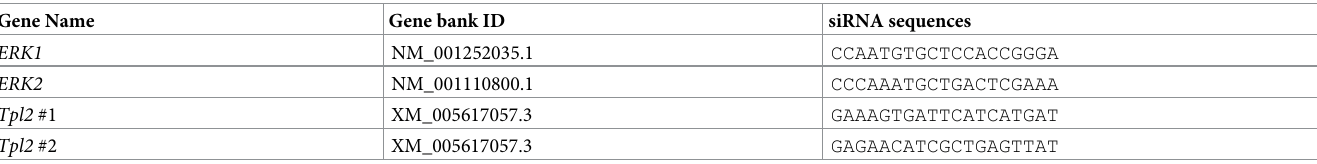
Table 2. Sequences for siRNA